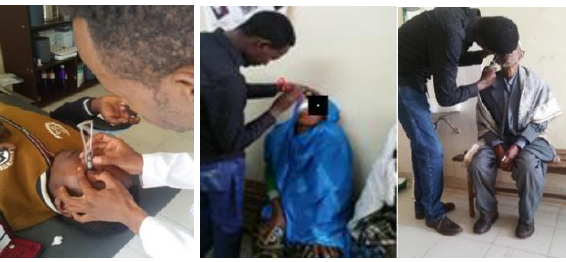
Figure 3: An ophthalmic nurse measuring intra- ocular pressure (left) and screening the optic disc, using torch light (middle) and a handheld ophthalmoscope